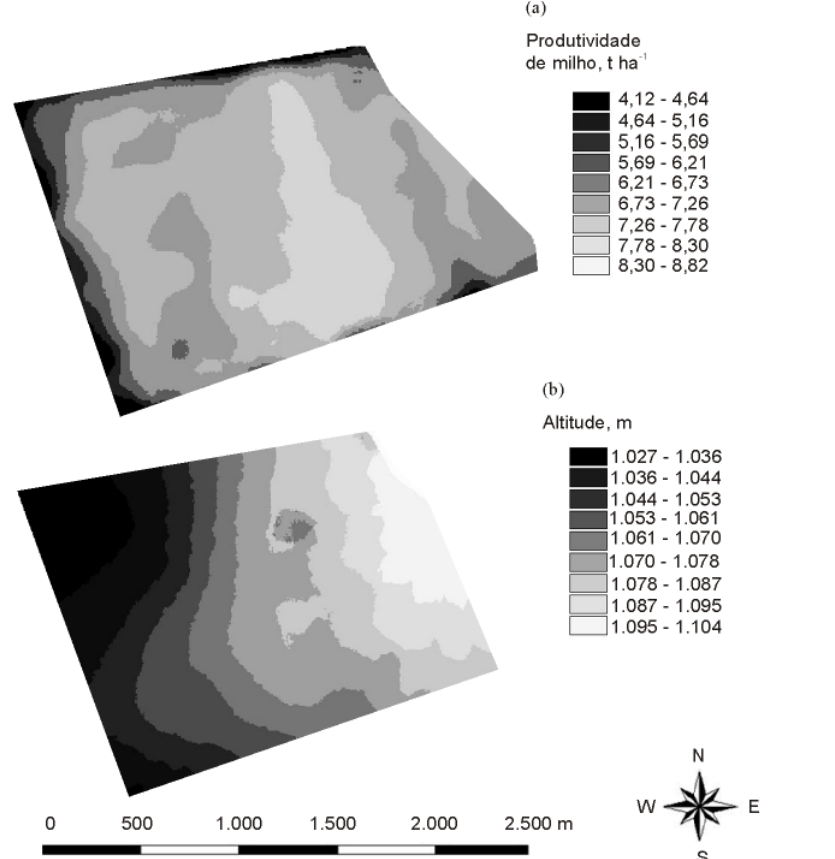
Figura 1. Mapas de produtividade de grãos de milho (a) e altitude em relação ao nível do mar